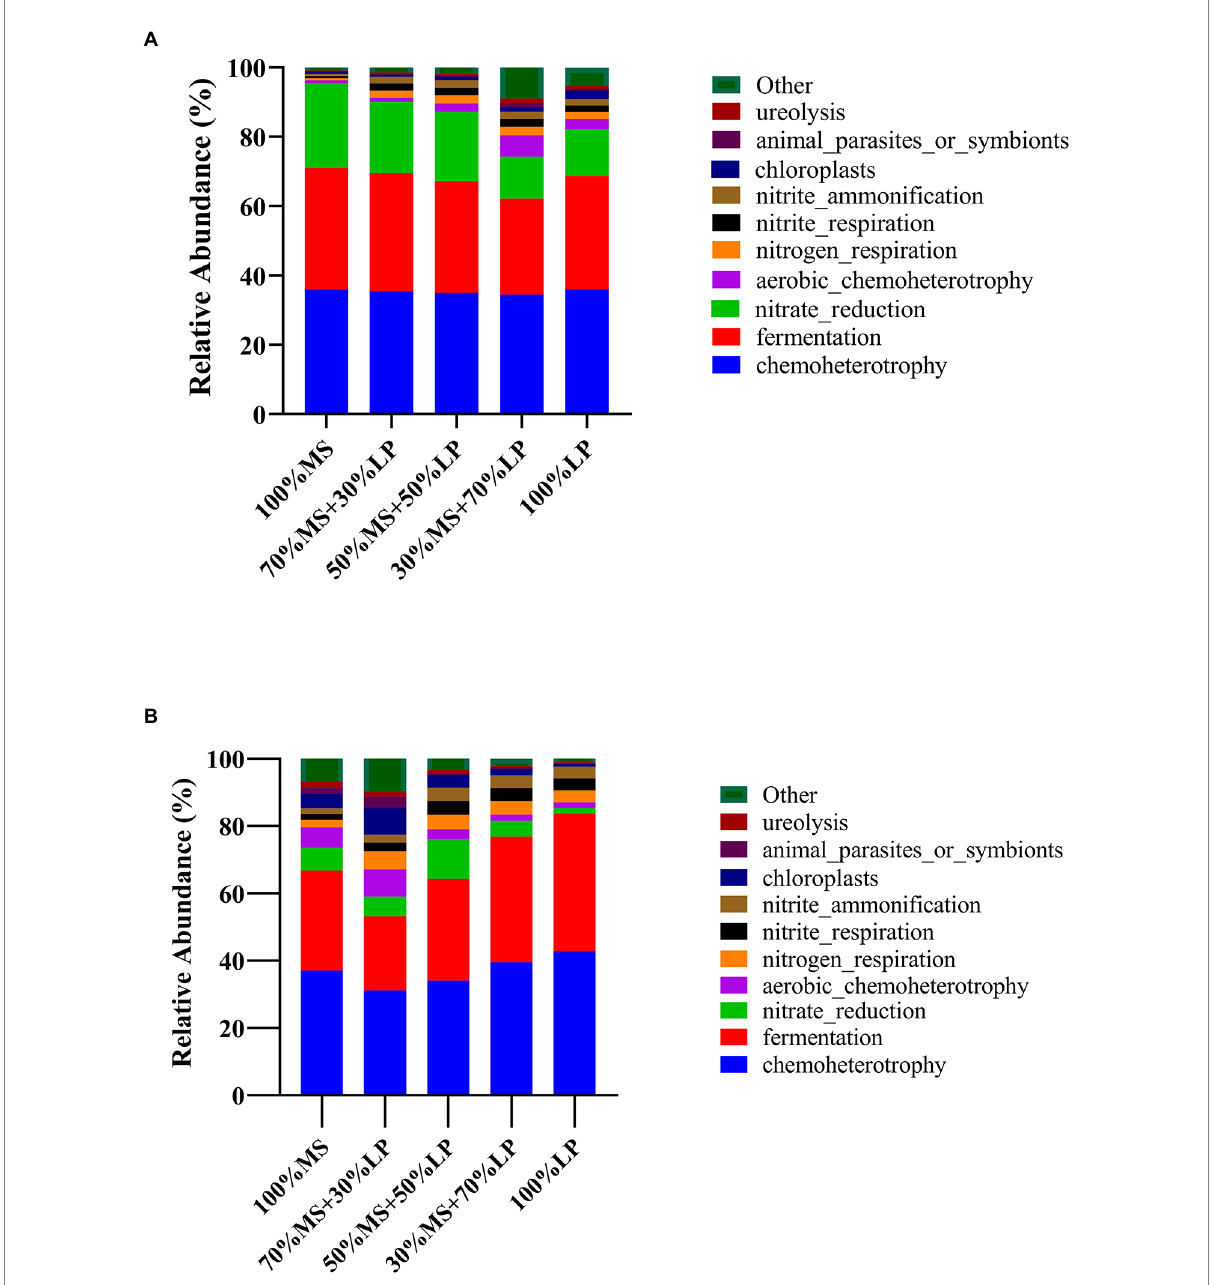
FIGURE 3 Dynamics of predicted microbial functional profiles of the relative abundances of the top 10 functions in alfalfa (MS) ensiled with perennial ryegrass (LP) silage for 7 (A) and 45 (B) days analyzed by Tax4Fun. 100% MS, 100% alfalfa; 70% MS + 30% LP, 70% alfalfa+30% perennial ryegrass; 50% MS + 50% LP, 50% alfalfa+50% perennial ryegrass; 30% MS + 70% LP, 30% alfalfa+70% perennial ryegrass; 100% LP, 100% perennial